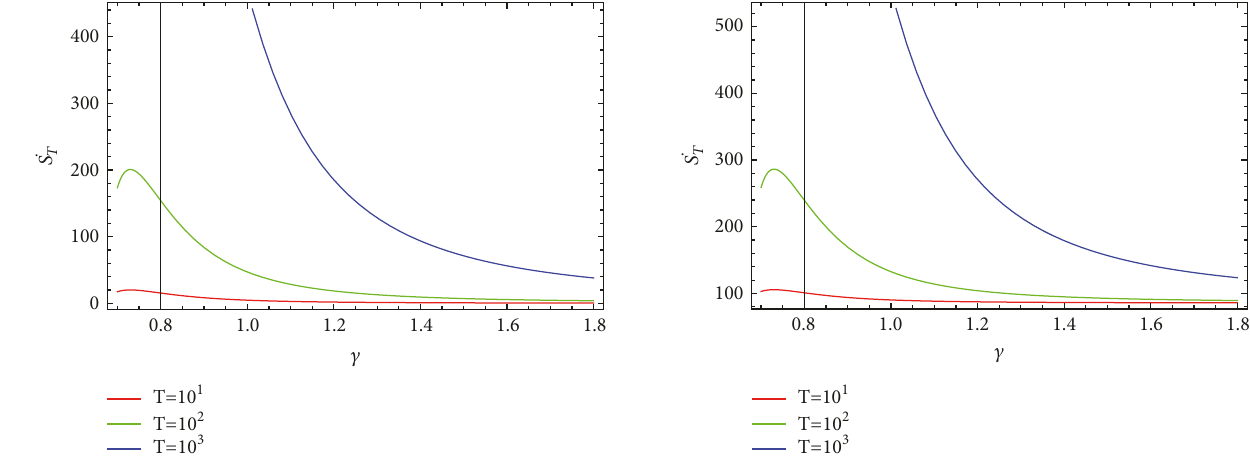
̇𝑆 𝛾 for Bekenstein entropy. Figure 2: Plot of ̇𝑆 Figure 1: Plot of 𝑇 versus